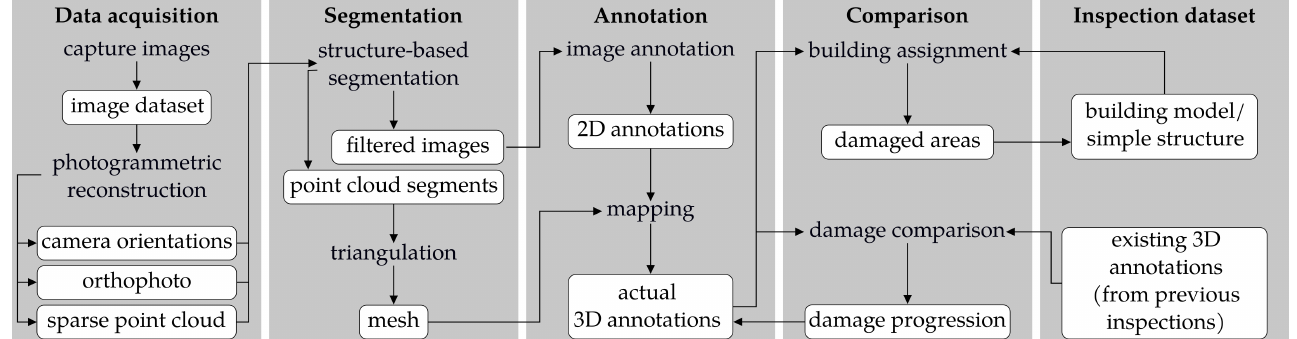
Figure 2. Flowchart of the proposed process pipeline to integrate 2D annotations in 3D models and to perform an automated damage comparison (data entities in the white boxes, processing steps without